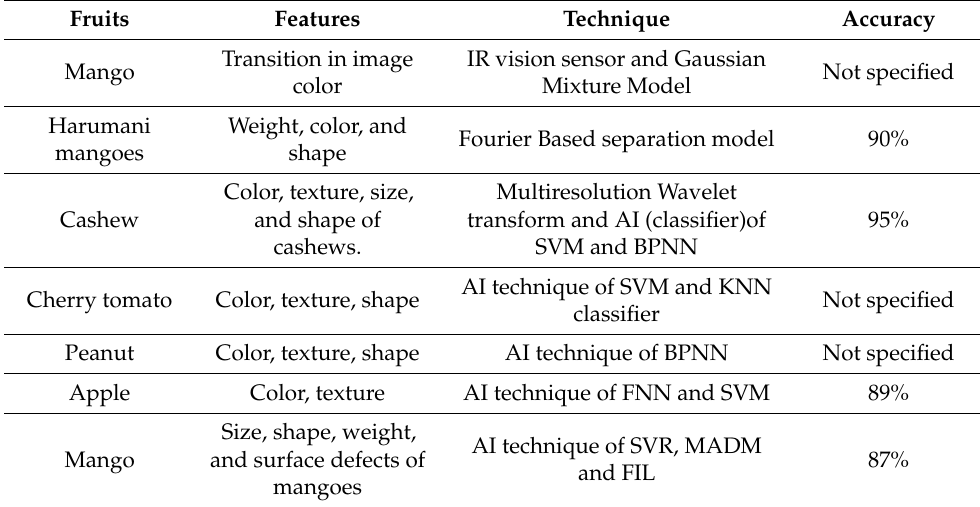
Table 3. Comparative analysis of